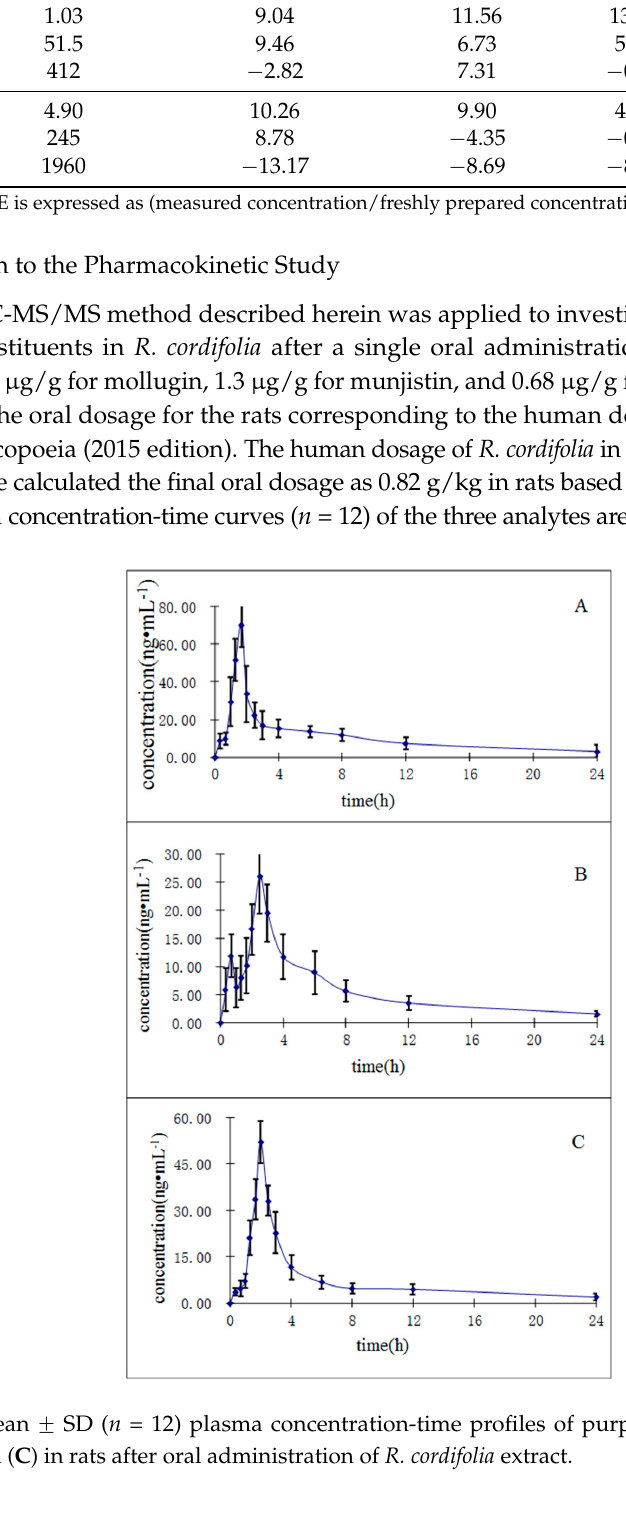
Table 5. Stabilities of the analytes in rat plasma ( n = 6).